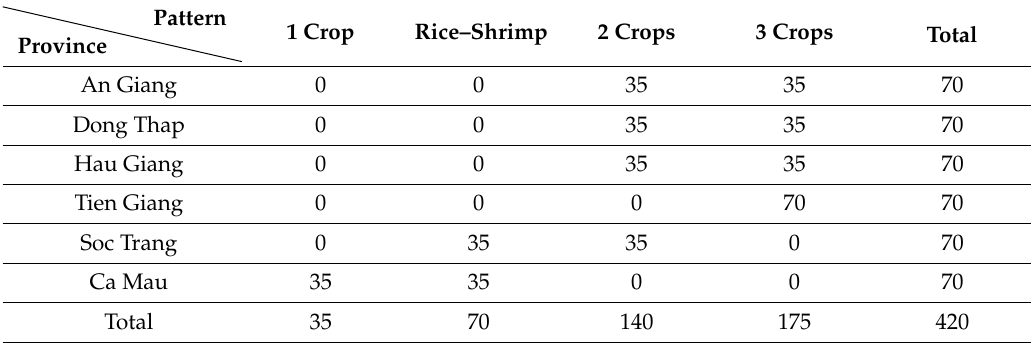
Table 1. Number of households surveyed by rice cropping pattern and